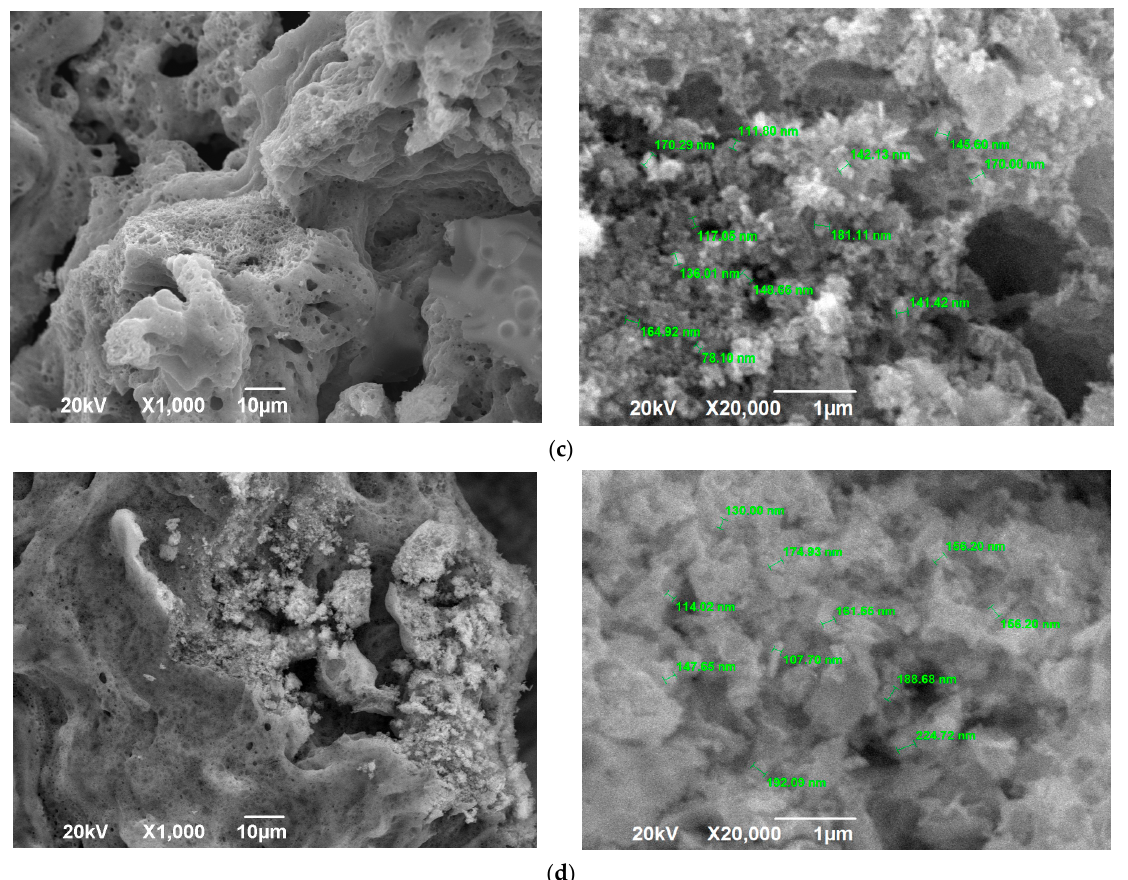
Figure 3. SEM images of the SCS product at various φ : ( a ) φ = 0.25; ( b ) φ = 1; ( c ) φ = 2; ( d ) φ = 3.